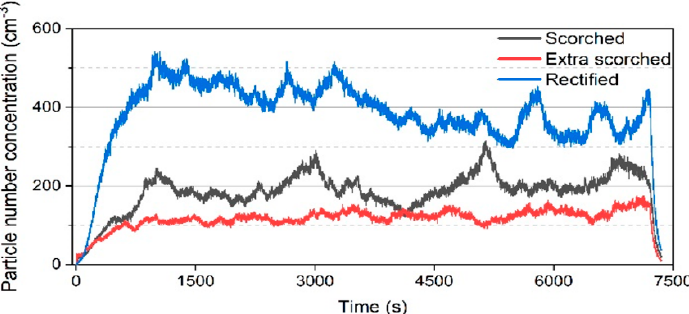
Figure 6. Representative measured particle number concentration curves for the three surface types.